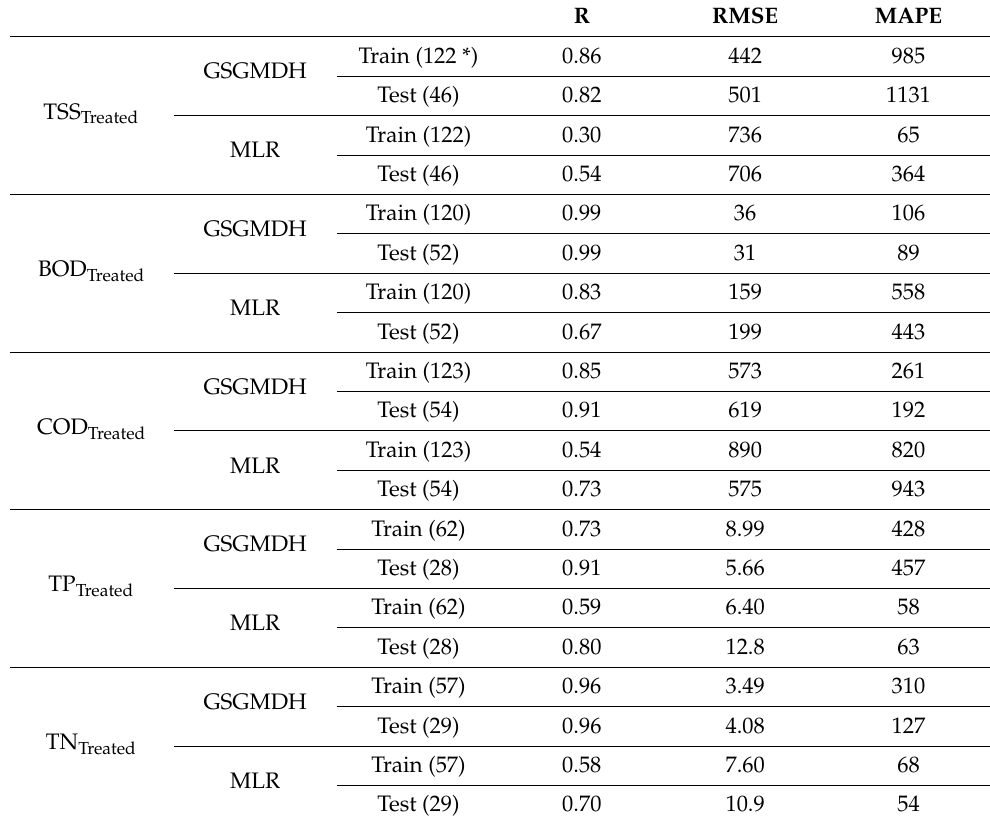
Table 5. Models generated for treated water quality parameters showing the input variables used and their corresponding R 2 and RMSE values for train and validation